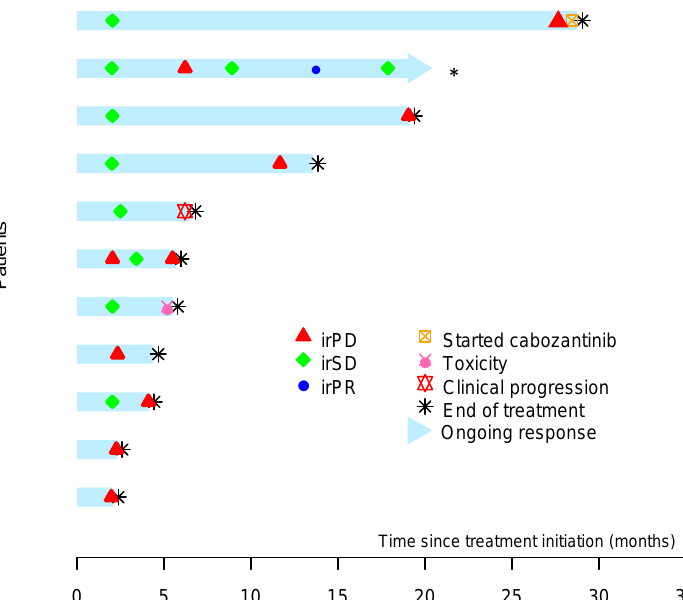
Figure 2. Swimmer plot of time to and duration of response in all patients treated with pembrolizumab. By the time of data cut-off, the second patient from the top was still experiencing a response *. The first patient from the top had stable disease for 24 months. Six patients died because of disease progression. The median progression free survival time was 5.7 months (95% CI = 4.37 — not reached) (Figure 3).